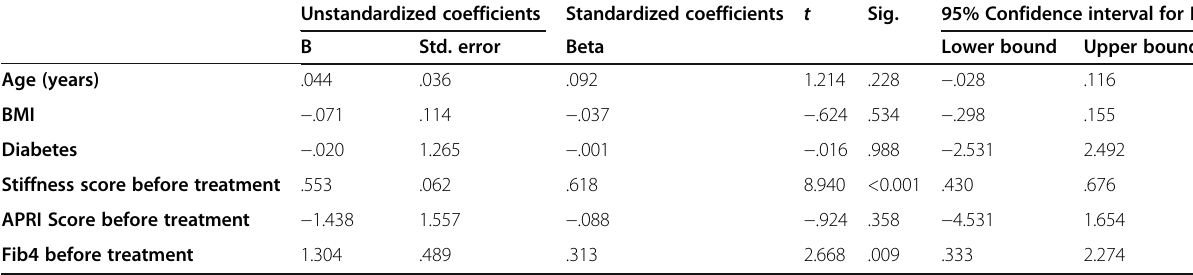
Table 7 Regression analysis for baseline factors affecting stiffness score after treatment Unstandardized